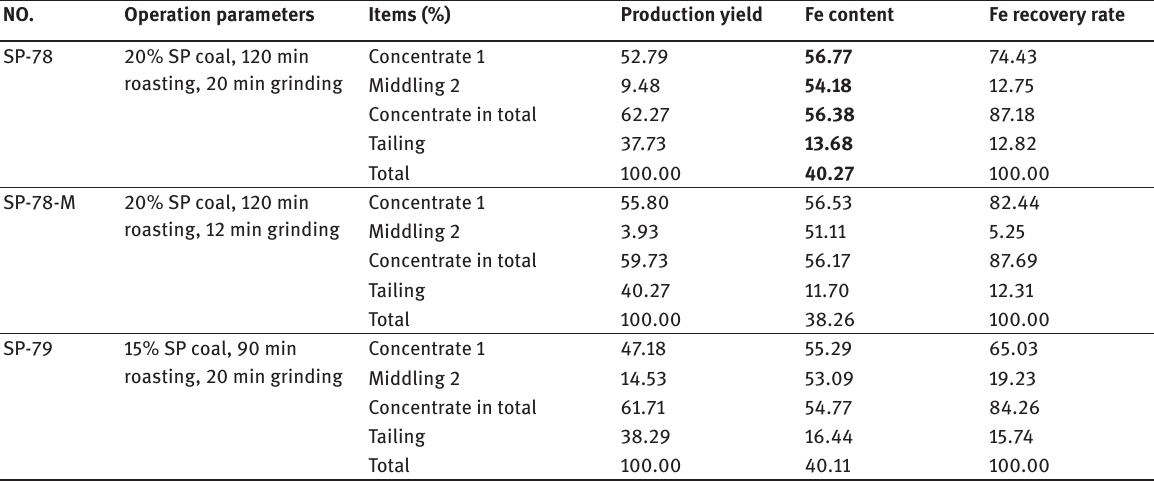
Table 11: Roasting of SP samples using SP coal at temperature 800 o C, magnetic field: 1.5A 0.8A. NO. Operation parameters Items (%) Production yield Fe content